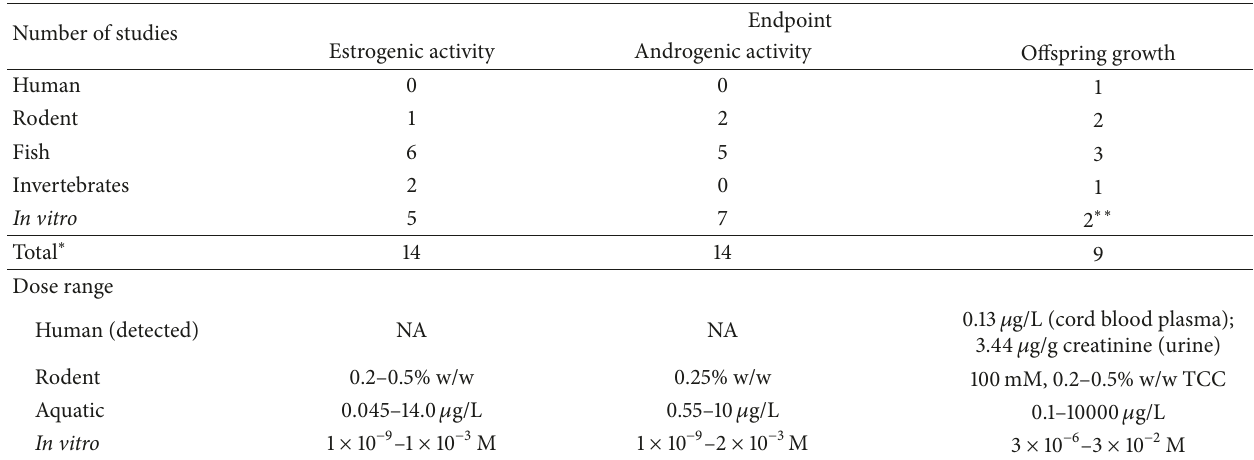
Table 6: Description of recommended systematic review endpoints.